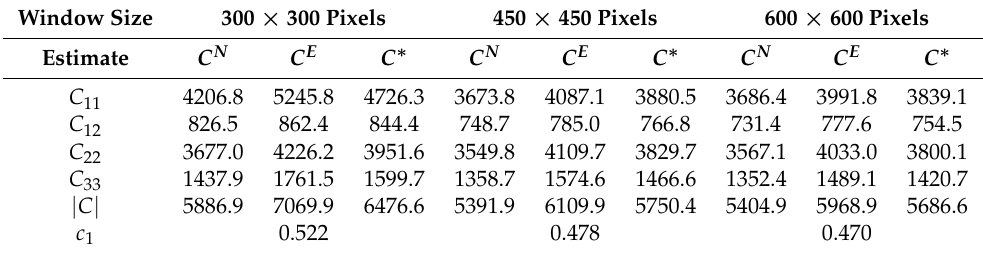
Table 1. Estimated of stiffness matrix for different size of test-window of the masonry sample. Window Size